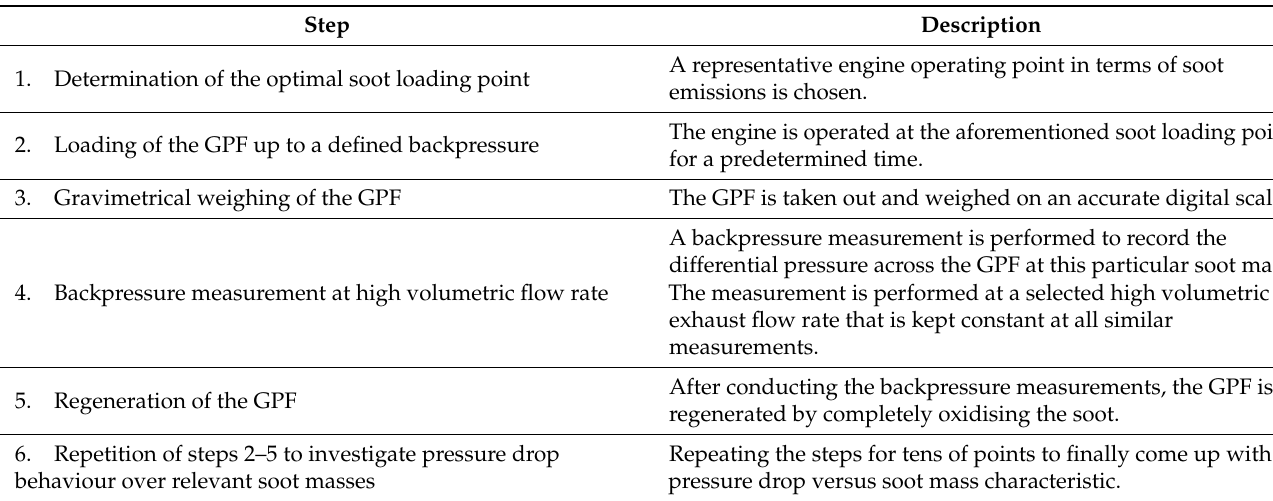
Figure 1. State-of-the-art GPF calibration workflow. Table 1. Pressure drop calibration